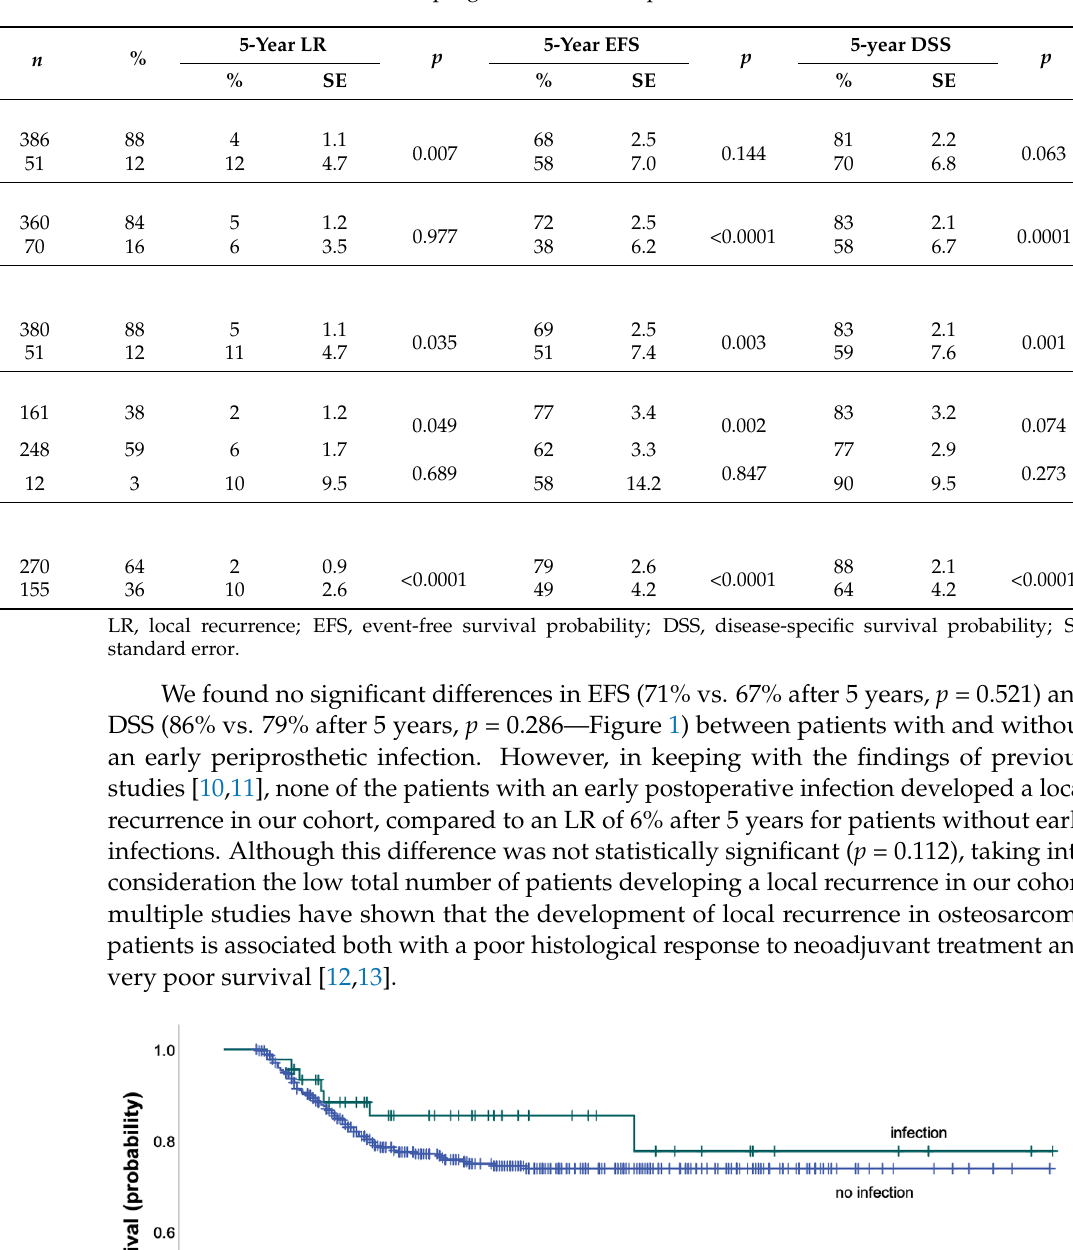
Table 2. The influence of known prognostic factors on patient outcome.